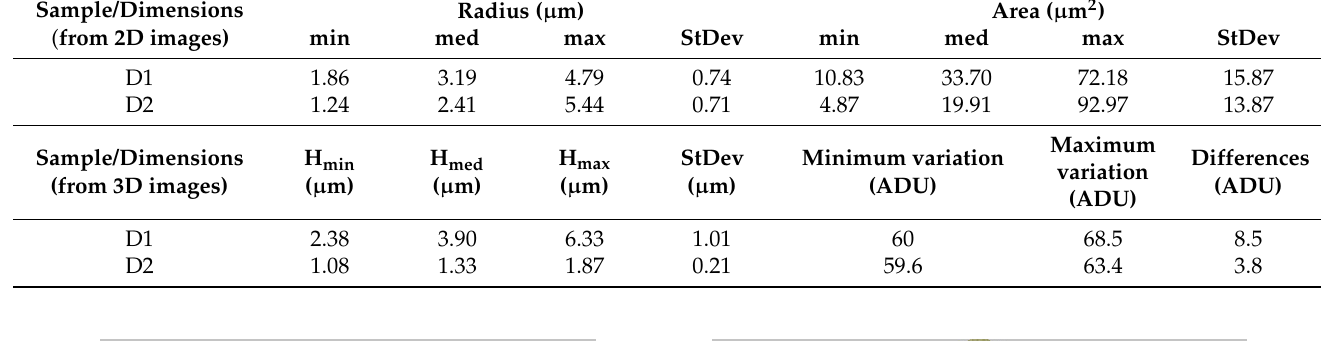
Table 1. Surface characteristics of samples D1 and D2 (values were obtained from Figure 3 using VegaT software). Sample/Dimensions